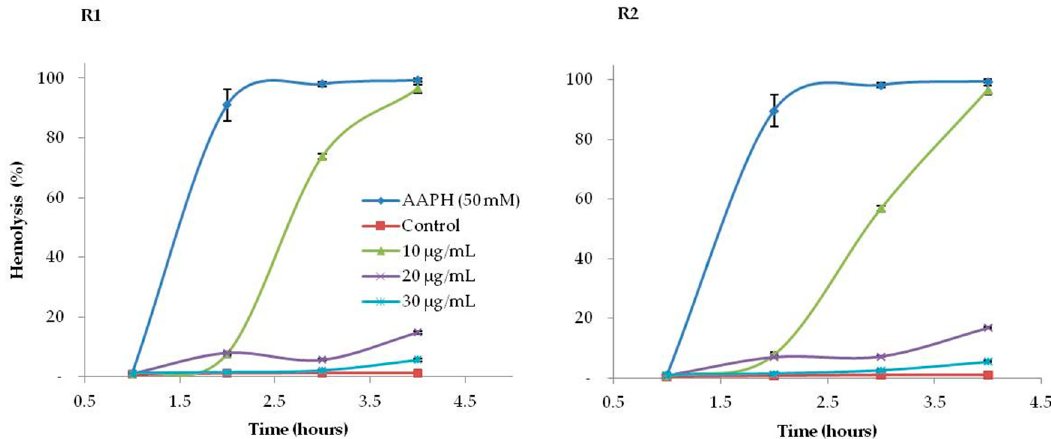
Figure 1. Hemolytic activity of L. lucidum berries, from the two Portuguese regions (R1—Lisbon and R2—Castelo Branco), incubated with erythrocytes and 0.9% NaCl solution for 240 min, without the presence of 2,2 ′ -azobis (2-methylpropionamidine) (AAPH). The control consists of erythrocytes incubated only with 0.9% NaCl solution.